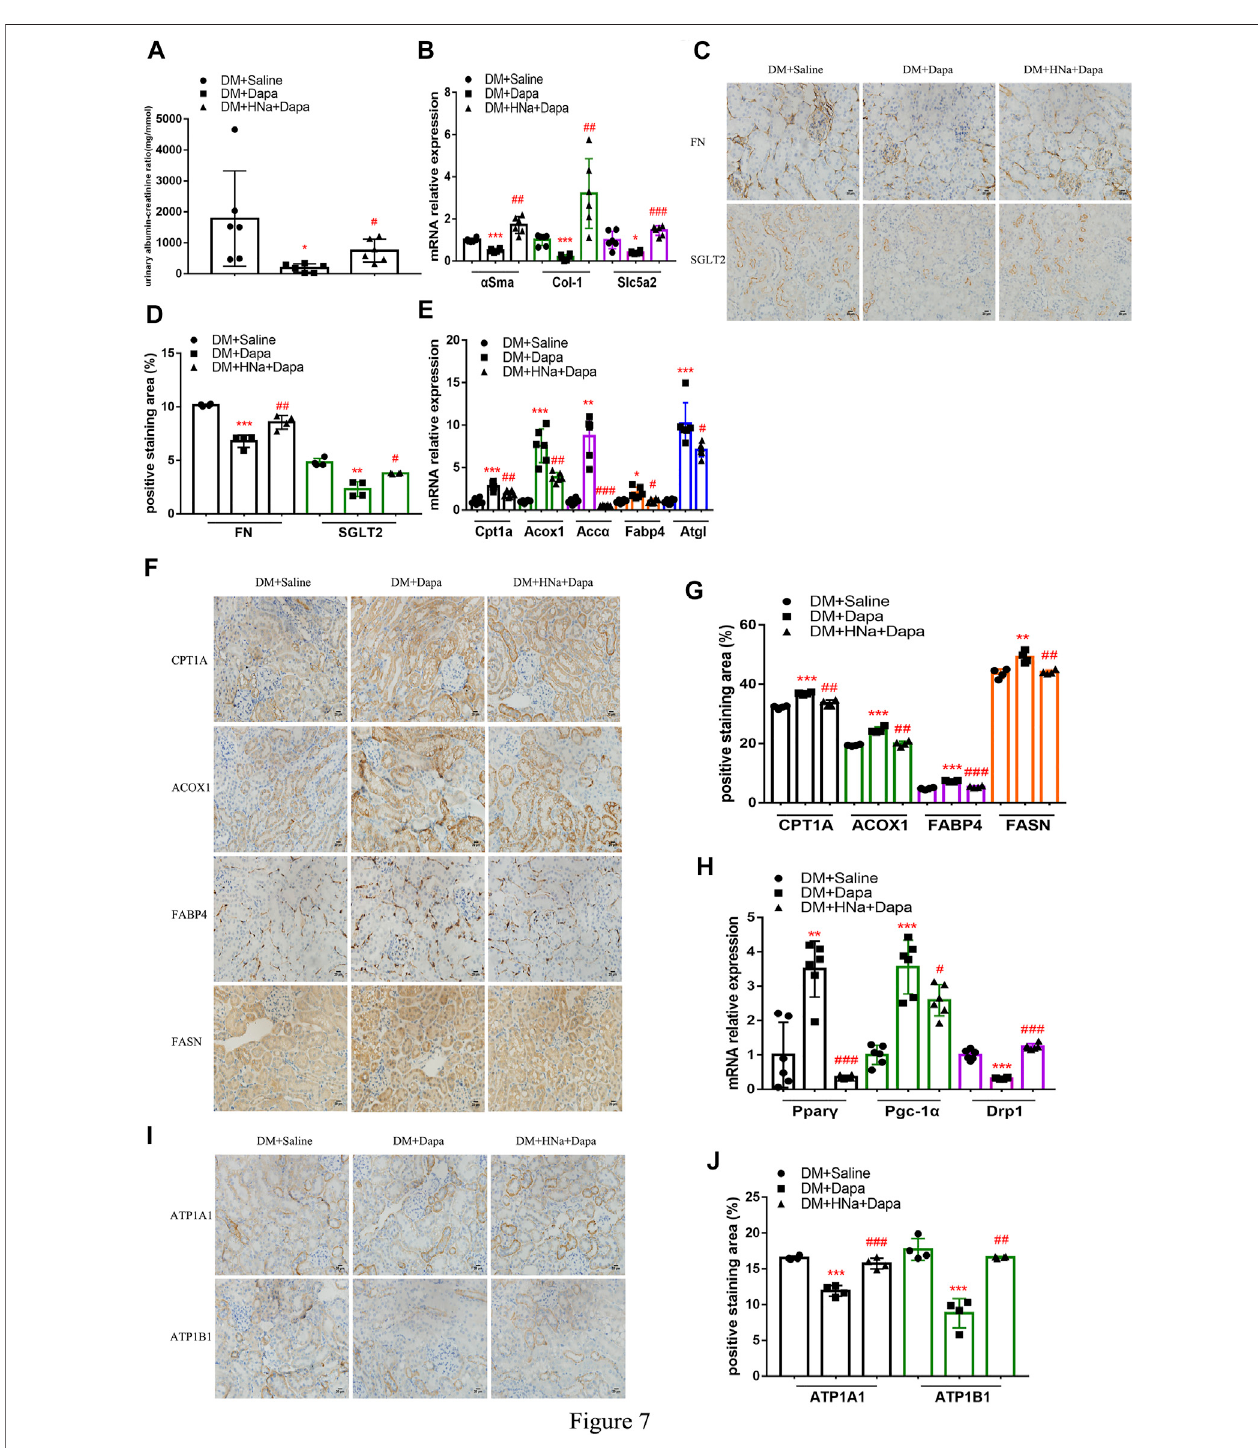
FIGURE 7 | | High-salt diet attenuates gene and protein expression in diabetic mice treated with dapagli fl ozin. (A) The detection of ACR ( n (cid:1) 6 per group). (B) Expression of α Sma, Col-1 and Slc5a2 genes in renal tubules after dapagli fl ozin treatment ( n (cid:1) 6per group). (C) Paraf fi n-embedded renal sections were stained with FN and SGLT2 antibodies (magni fi cation, 400 × , bar (cid:1) 20 μ m). (D) Histopathological assessment ofFN and SGLT2 proteins ( n (cid:1) 4 per group). Expression of genes involved infattyacidmetabolism (E) andmitochondrialbiosynthesis (H) inrenaltubulesafterdapagli fl ozintreatment( n (cid:1) 6pergroup). (F,I) Paraf fi n-embeddedrenalsections were stained with CPT1A, ACOX1, FABP4, FASN, ATP1A1 and ATP1B1 antibodies (magni fi cation, 400 × , bar (cid:1) 20 μ m). (G,J) Histopathological assessmentof CPT1A, ACOX1, FABP4, FASN, ATP1A1 and ATP1B1proteins ( n (cid:1) 4 per group). All data are mean ± SEM, * p < 0.05, ** p < 0.01 and *** p < 0.001 vs. DM + Saline group; # p < 0.05, ## p < 0.01 and ### p < 0.001 vs. DM + Dapa group.